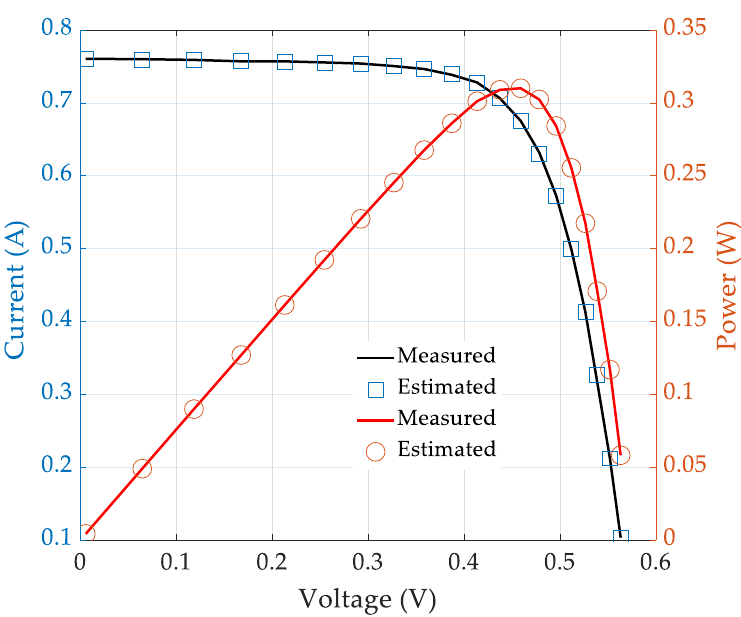
Figure 3. I-V and P-V characteristics curve for estimated and experimental values for single-diode model of R.T.C France solar cell.